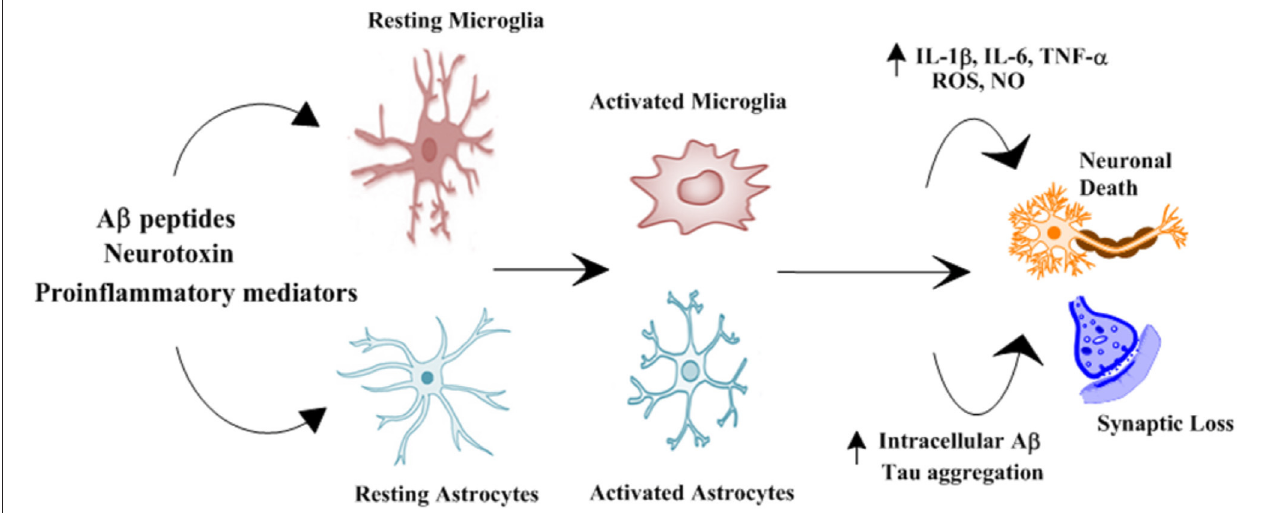
FIGURE 1 | Schematic representation of role of glial cells in pathophysiology of Alzheimer’s disease. Numerous stimuli such as A β peptides, neurotoxin and proinflammatory mediators activates microglial cells and astrocytes. Activated microglial cells and astrocytes results in increased production of proinflammatory cytokines and intracellular A β and Tau aggregation resulting in synaptic loss and neuronal death ( Morales et al.,